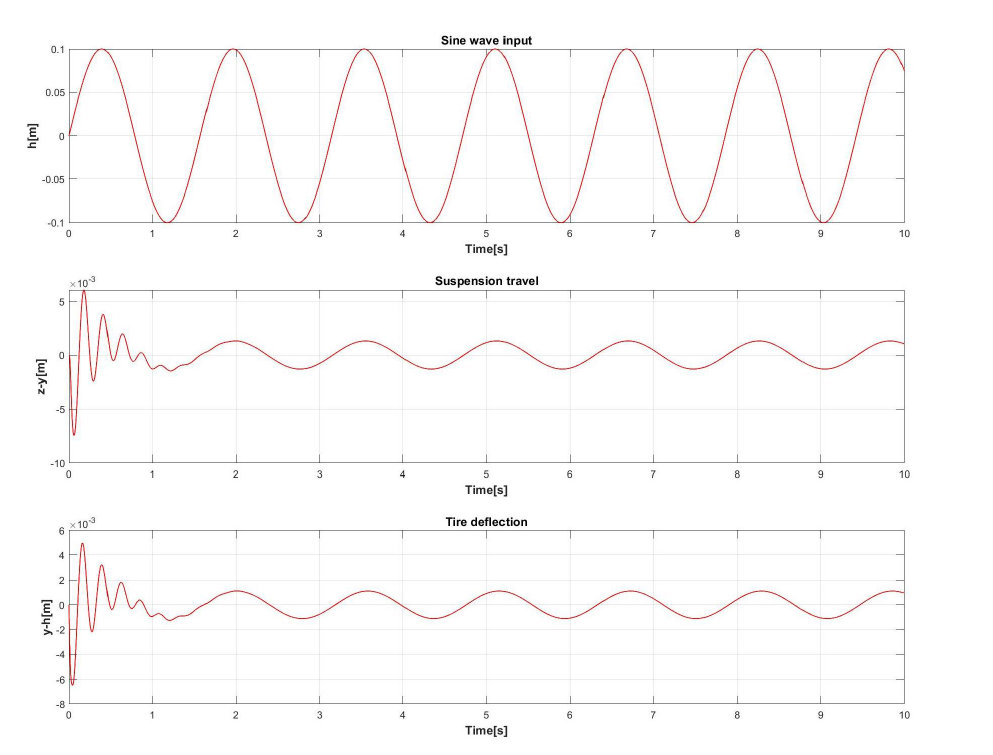
Figure 16. Quarter Car model response in terms of suspension travel and tire deflection to a sine wave input of 0.1 m of amplitude for a 10 s simulation time.